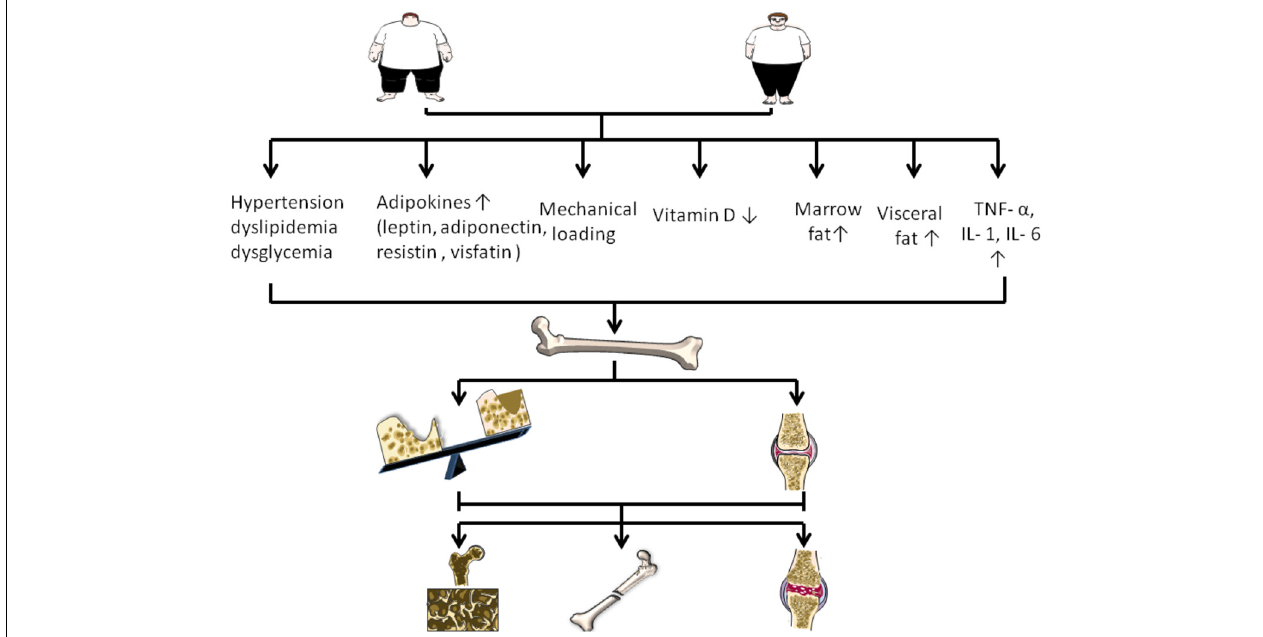
FIGURE 1 | Changes of various factors caused by obesity on the regulation of bone disease. Obesity can increase mechanical load, visceral fat and bone marrow fat. In addition, obesity is associated with increased adipokines, increased TNF – or, IL-1, IL- 6, decreased vitamin D, and accompanied by hypertension, dyslipidemia, and dysglycemia. They regulate bone disease by affecting bone formation, bone resorption, and cartilage.